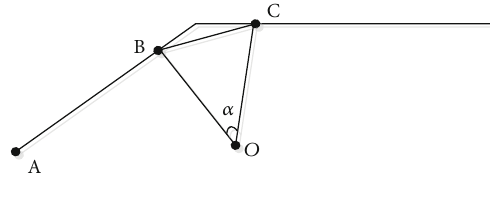
Figure 2: Arc trajectory algorithm.